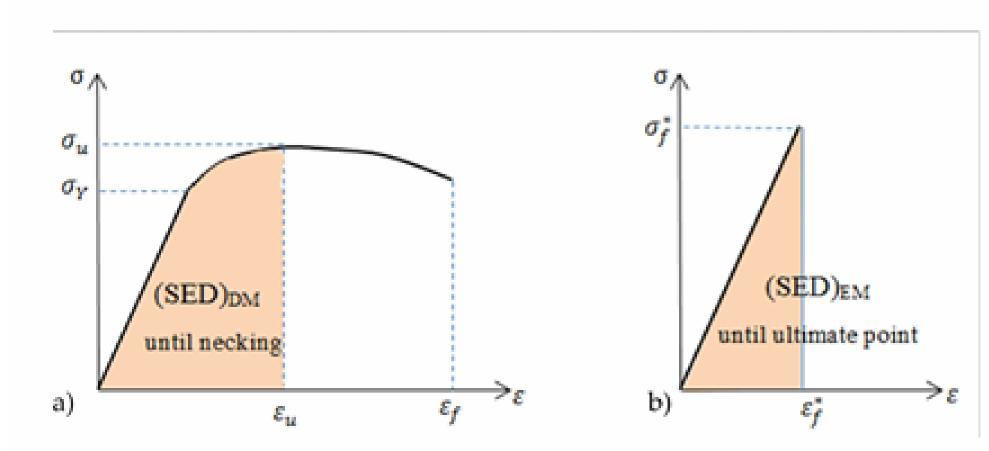
Figure 2. Schematic of tensile stress–strain curves: ( a ) ductile material; ( b) equivalent